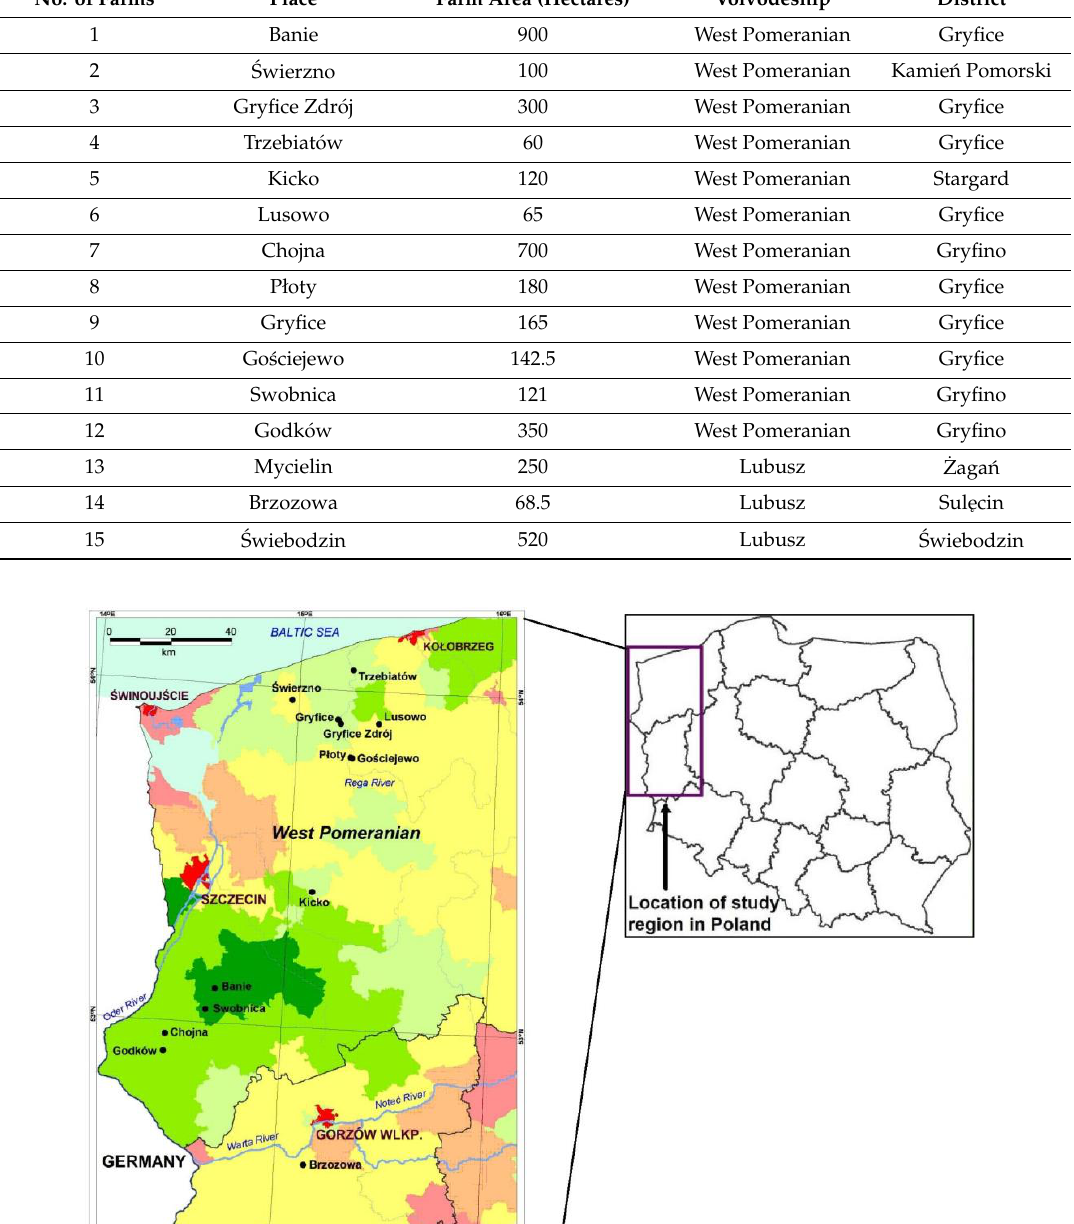
Table 1. Location and area of study farms.